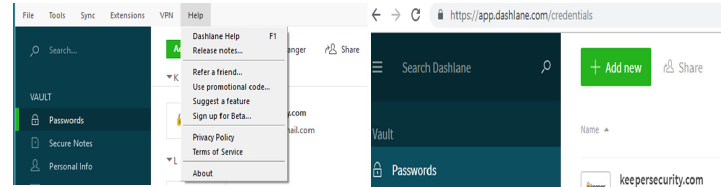
Figure A22. The application has all the features and functions, while the webpage does